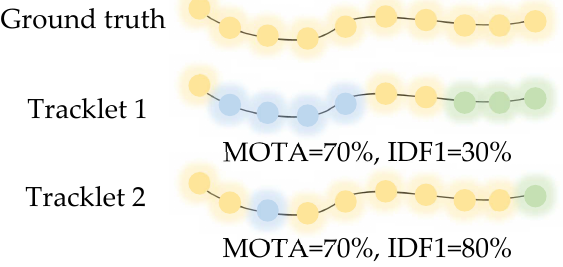
Figure 9. The importance of joint MOTA and IDF1. Different colors indicate different IDs. The MOTA is the same for both tracklets, but tracklet 2 with a higher IDF1 is obviously the superior